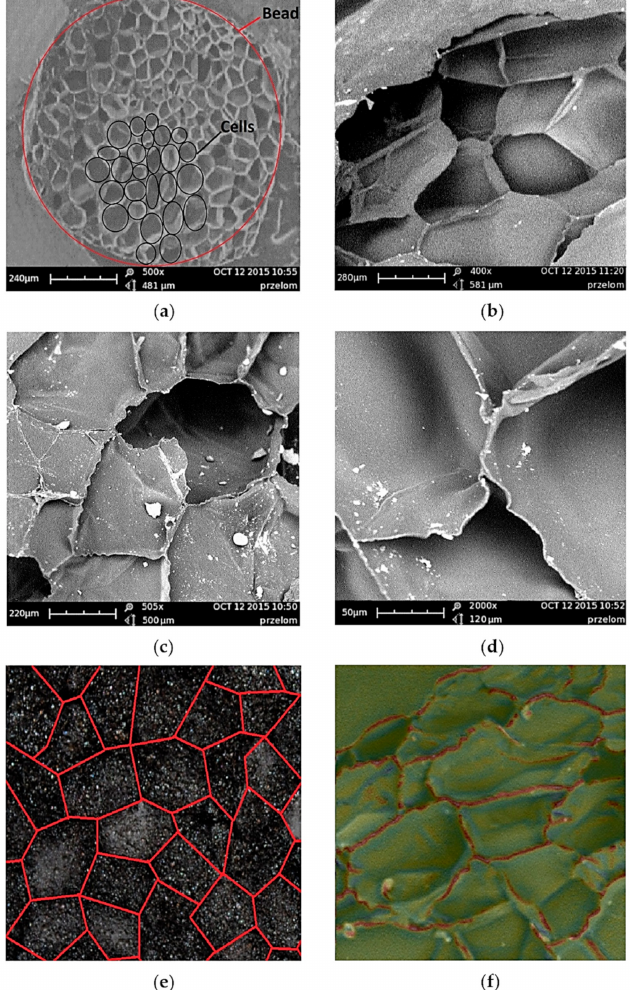
Figure 1. Scanning electron microscope (SEM) microphotographs cellular structure of expanded polypropylene (EPP) of density ρ = 20g/dm 3 ( a – d ) microphotograph structure bead ( e ) diagram and photograph structure bead ( f ) morphology structure closed